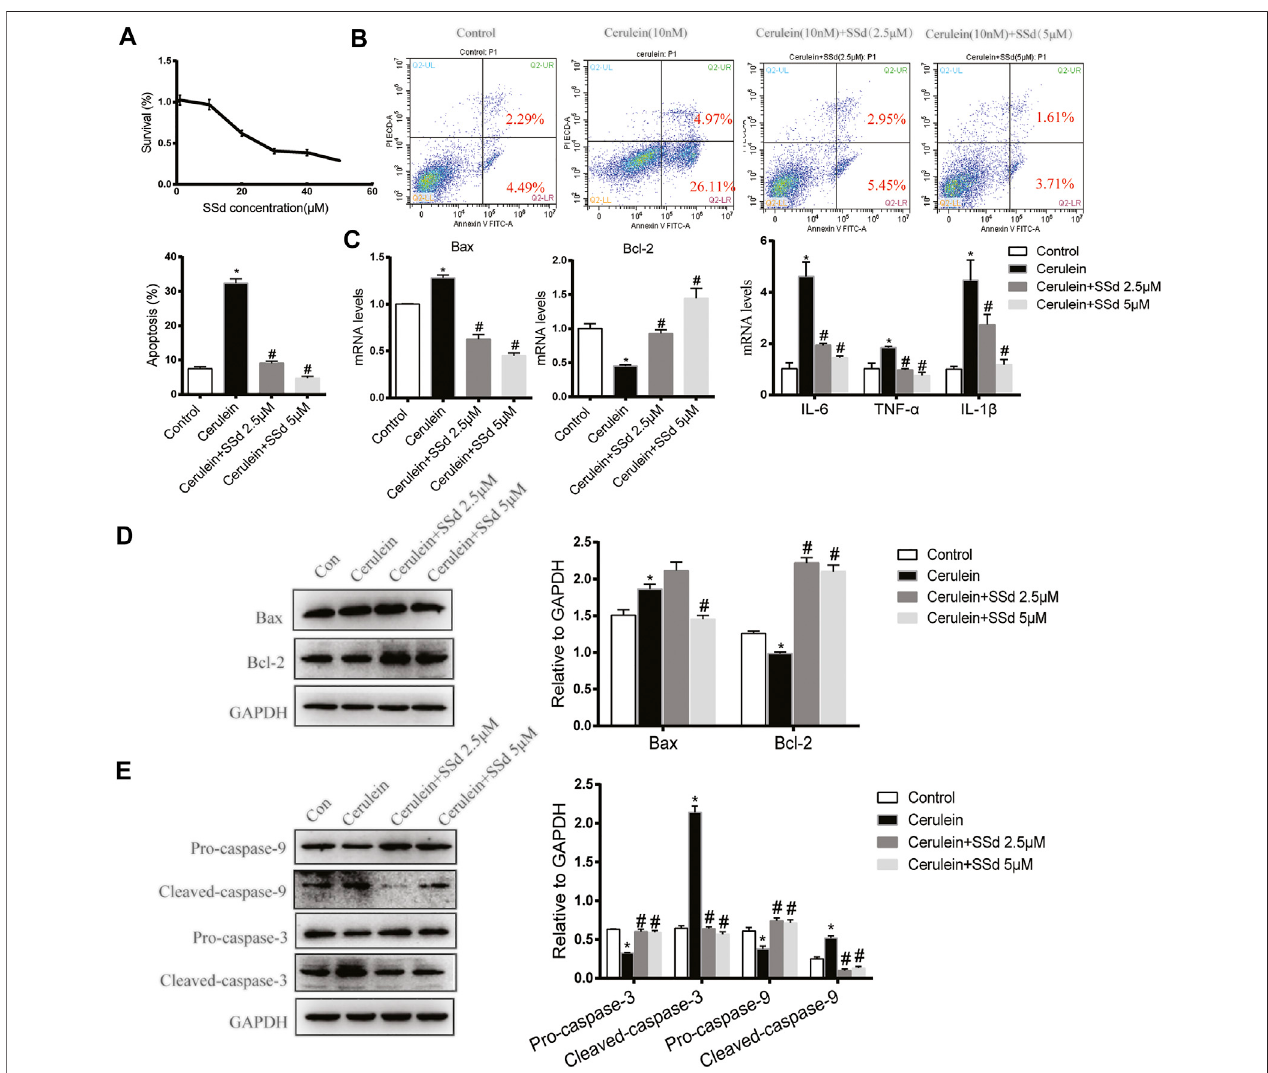
FIGURE 4 | SSd attenuated apoptosis and in fl ammation of AR42J cells induced by cerulein. (A) CCK8 assay detected the cell viability of AR42J after SSd treatment. (B) Flow cytometry analysis of apoptosis of AR42J. AR42J were pre-treated with cerulein 10 nM for 1 h, then incubated with or without 2.5 μ M or 5 μ M SSd for 24 h. (C) RT-PCR analysis of Bax, Bcl-2, IL-6, TNF- α , and IL-1 β . (D) Western blot analysis of Bax and Bcl-2. (E) Western blot analysis of C Pro-caspase-3, Cleaved- caspase-3, Pro-caspase-9, and Cleaved-caspase-9. Dataare shown asthe mean ± SEM of at least three independent experiments (* p < 0.05 compared with the control group, # p < 0.05 compared with the cerulein induced